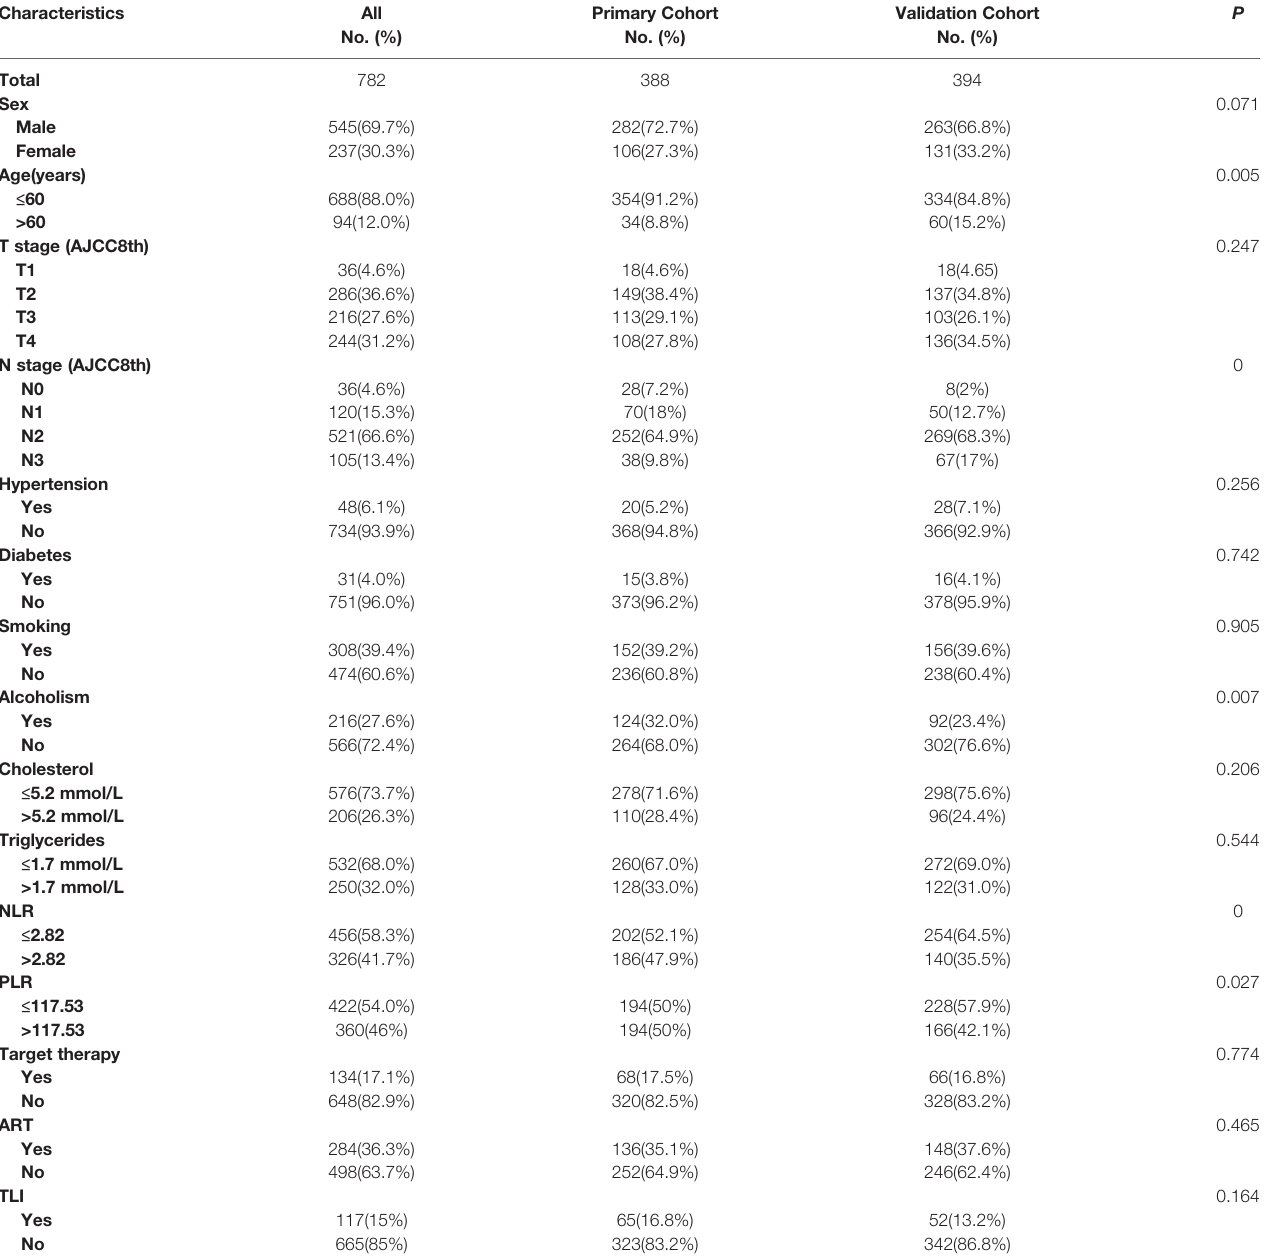
TABLE 1 | Clinical characteristics of 782 temporal